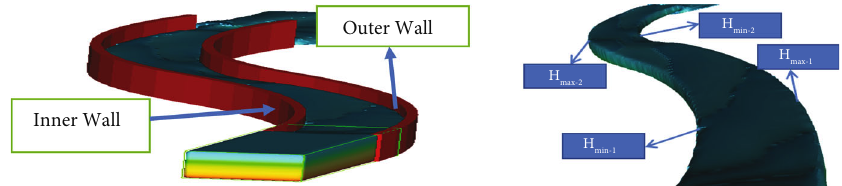
Figure 7: Numerical modeling of the bottom outlet-water surface.